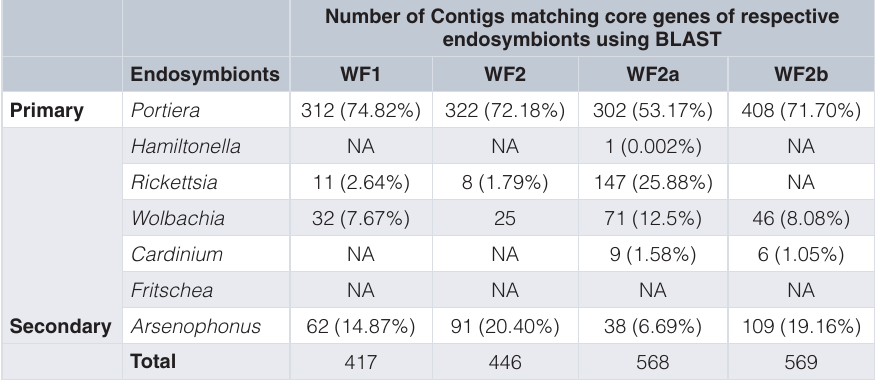
Table 2. Number of Contigs matching the core genes of bacteria endosymbionts across the four SSA1 whitefly